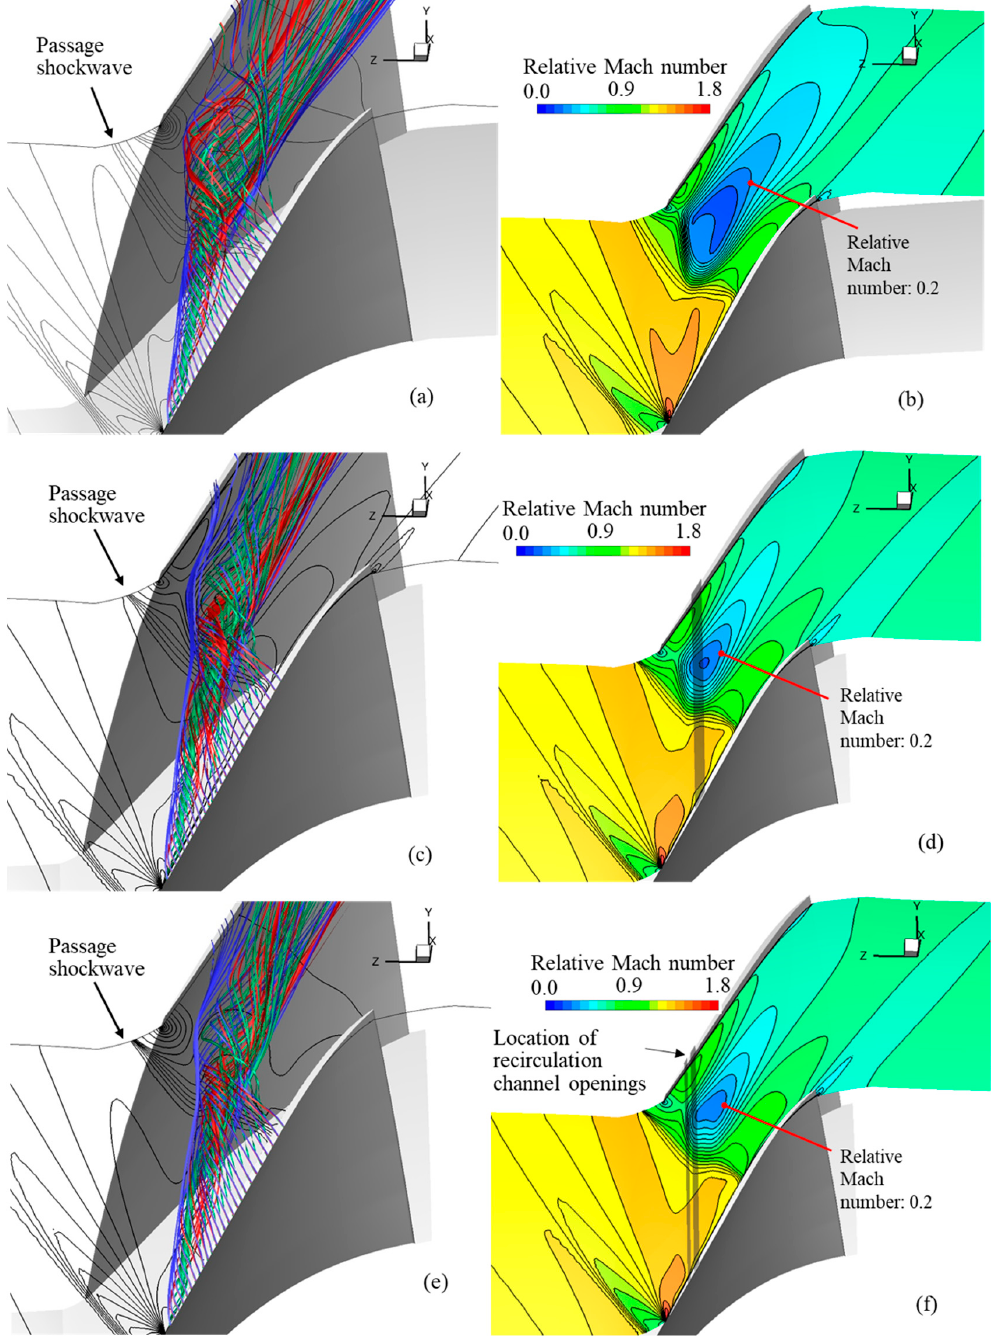
Figure 9. Analysis of the passage flow structures showing comparisons of the vortex breakdown and of the low-velocity region. ( a ) Streamlines and static pressure contours on 95% span surface ( ∆ P = 10kPa), BL (OP-D); ( b ) relative Mach number contours on 95% span surface, BL (OP-D); ( c ) streamlines and static pressure contours on 95% span surface ( ∆ P = 10kPa), SG (OP-D); ( d ) relative Mach number contours on 95% span surface, SG (OP-D); ( e ) streamlines and static pressure contours on 95% span surface ( ∆ P = 10kPa), RC (OP-D); ( f ) relative Mach number contours on 95% span surface, RC